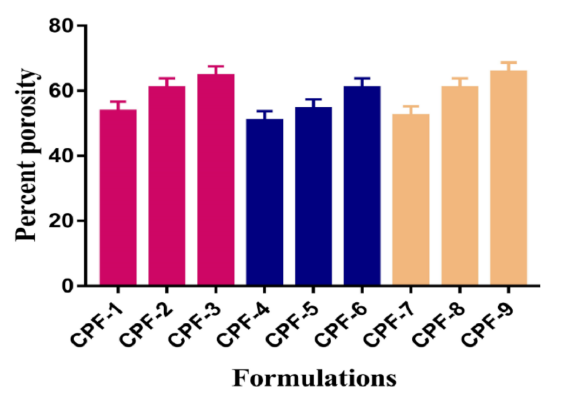
Figure 6. Percent porosity of CP/SpScPAA